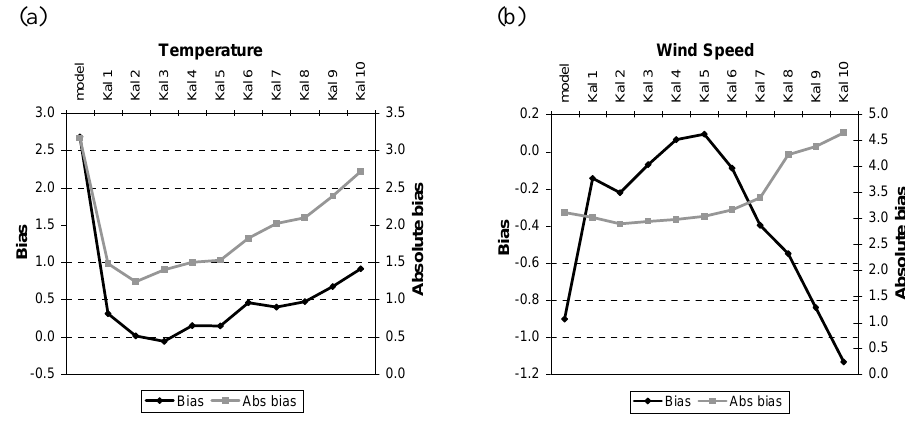
Fig. 4. Bias and absolute bias of (a) temperature and (b) wind speed for model and different Kalman filters outputs (Case I).